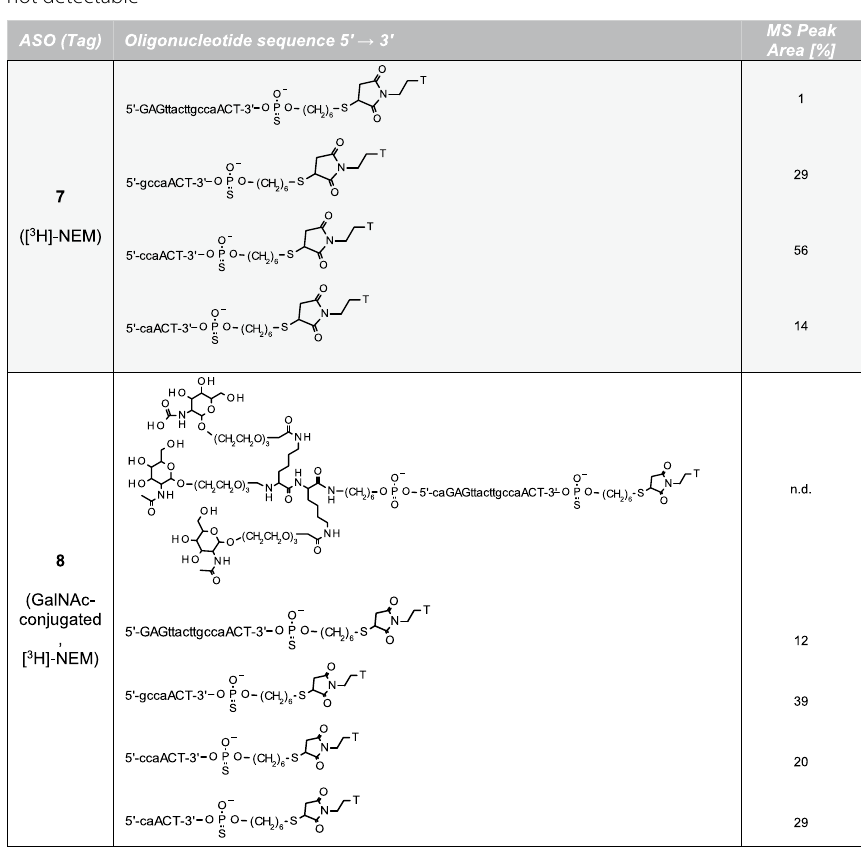
Table 3 Most abundant metabolites observed in urine of mice from 0 to 24 h after a single dose of [ 3 H]-NEM-labeled ASOs 7 and 8. Capital letters in the oligonucleotide sequence describe LNA-modified nucleosides, and small letters describe DNA nucleosides. n.d. not